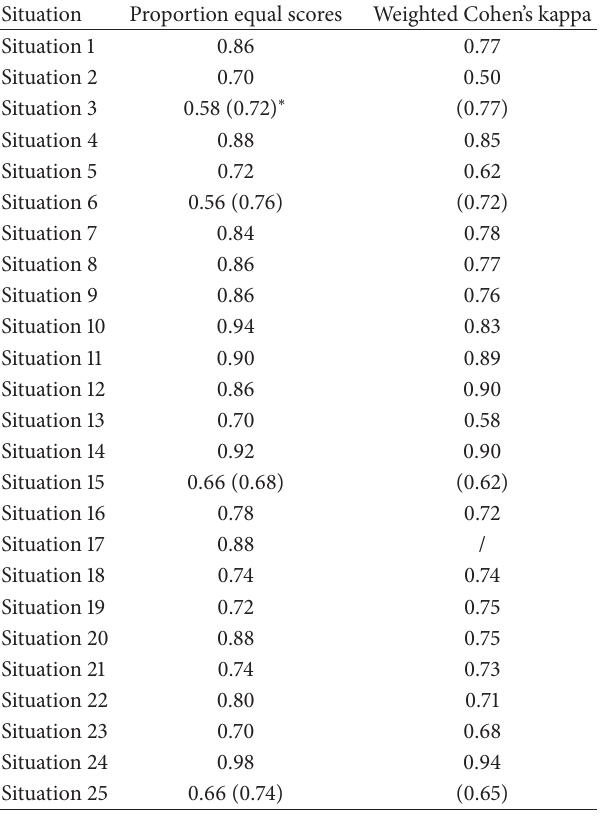
Table 4: Interrater reliabilities for the constructed-response items of the HCTA ( 𝑁 = 50